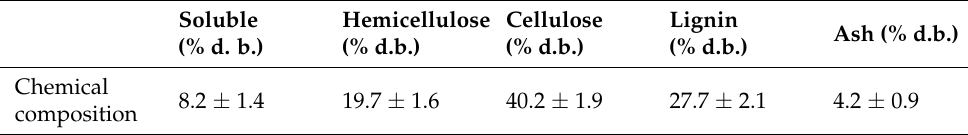
Table 1. Chemical composition of flax shives.